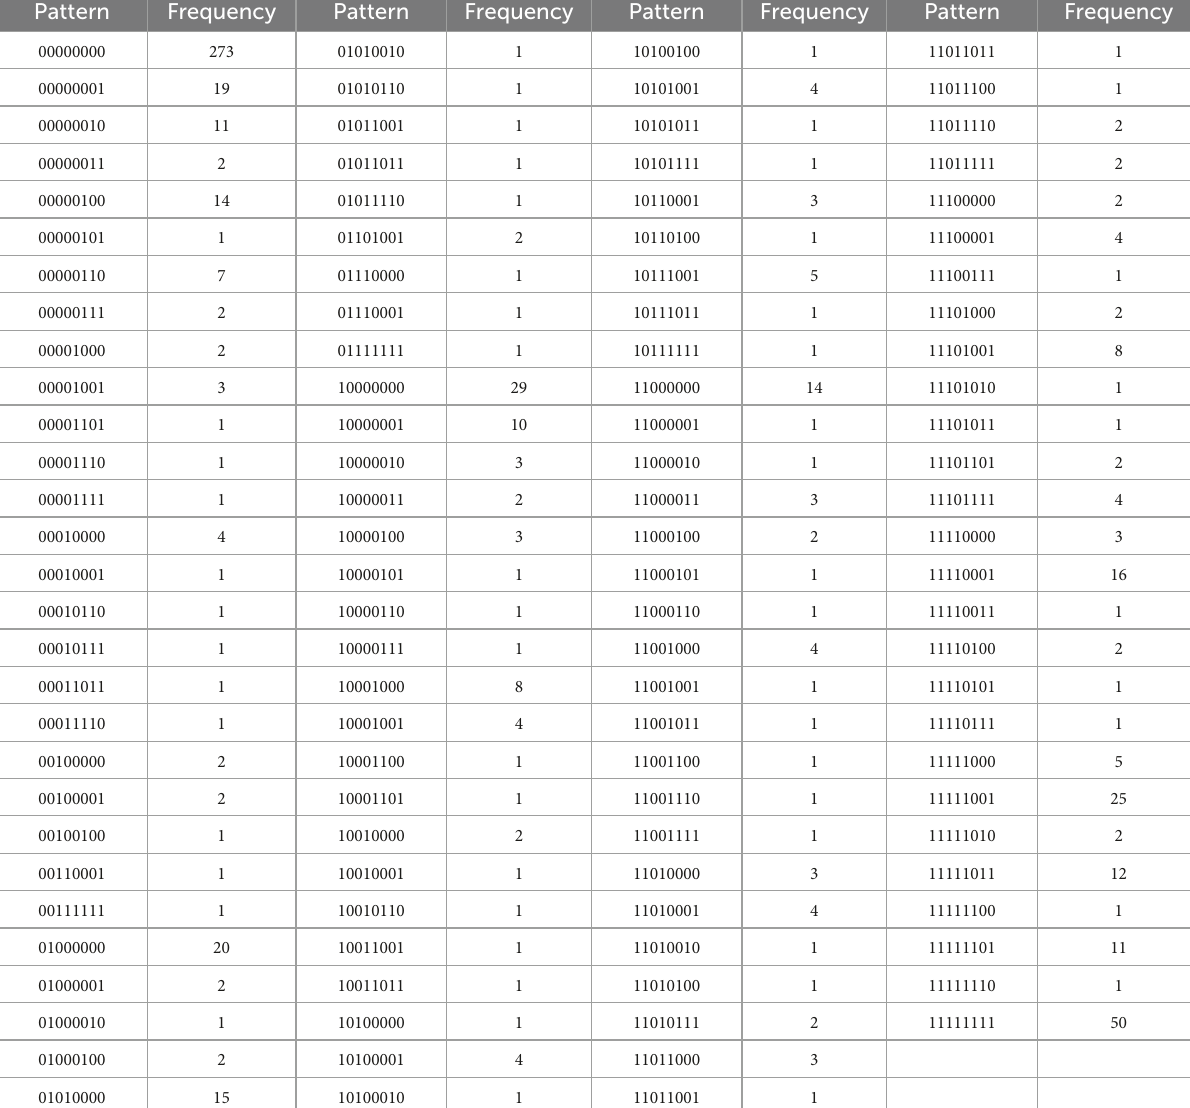
TABLE 4J For C = { d 5 , j 1 ,..., j 4 , e 1 , e 2 , e 5 } , with N = 706, k = 8 items, and u = 114 unique response patterns ( Appendix B